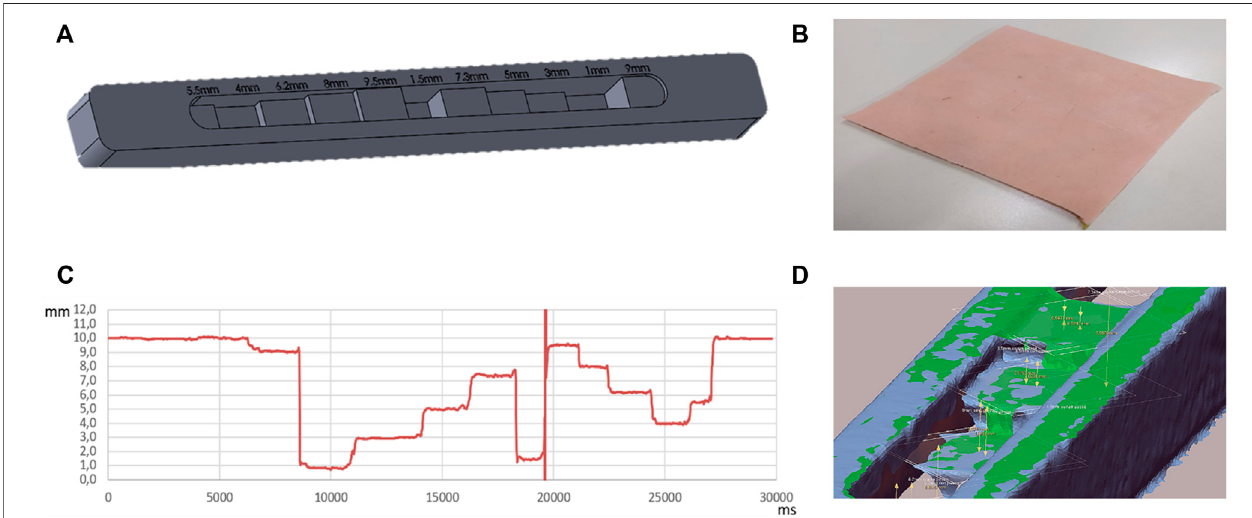
FIGURE7|(A) AdhocspecimenforLPG-Dsensitivitytest; (B) Siliconskinspecimen; (C) Ad-hocstepheightevaluationwithLPG-D;onthex-axisthetimevaluein millisecondsandonthey-axisthedistanceinmillimetres; (D) Plangenerationanddistanceevaluation.Comparisonbetweenscanswithandwithouttheadapter(ingreen with the adapter in blue without).